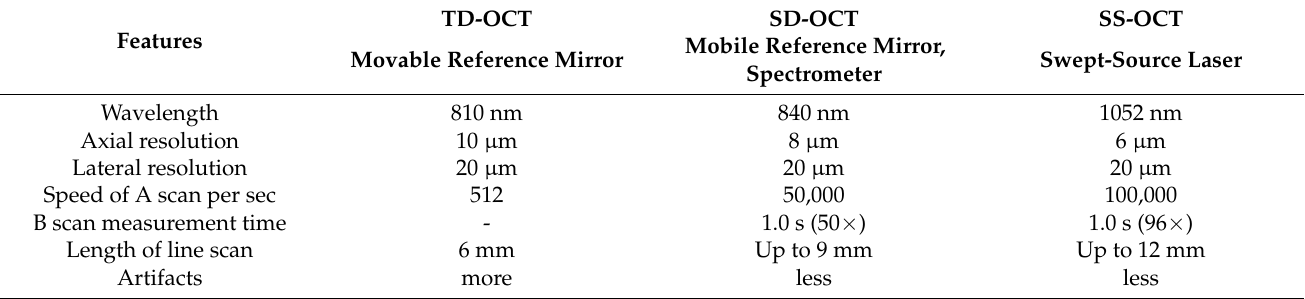
Table 1. Features of various optical coherence tomography